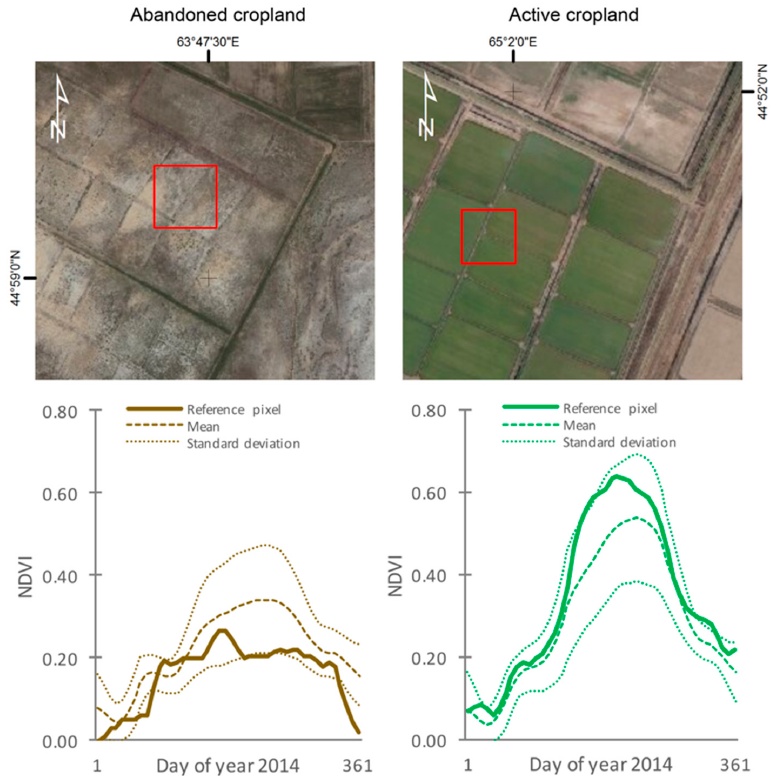
Figure 4. Abandoned ( left ) and active cropland ( right ) MODIS pixels (red squares). The graphs show the mean normalized difference vegetation index (NDVI) of all active and abandoned reference pixels (dashed signatures) and standard deviations (dotted lines). Bold lines represent the NDVI signatures of the two selected reference pixels (Source: Google Earth TM